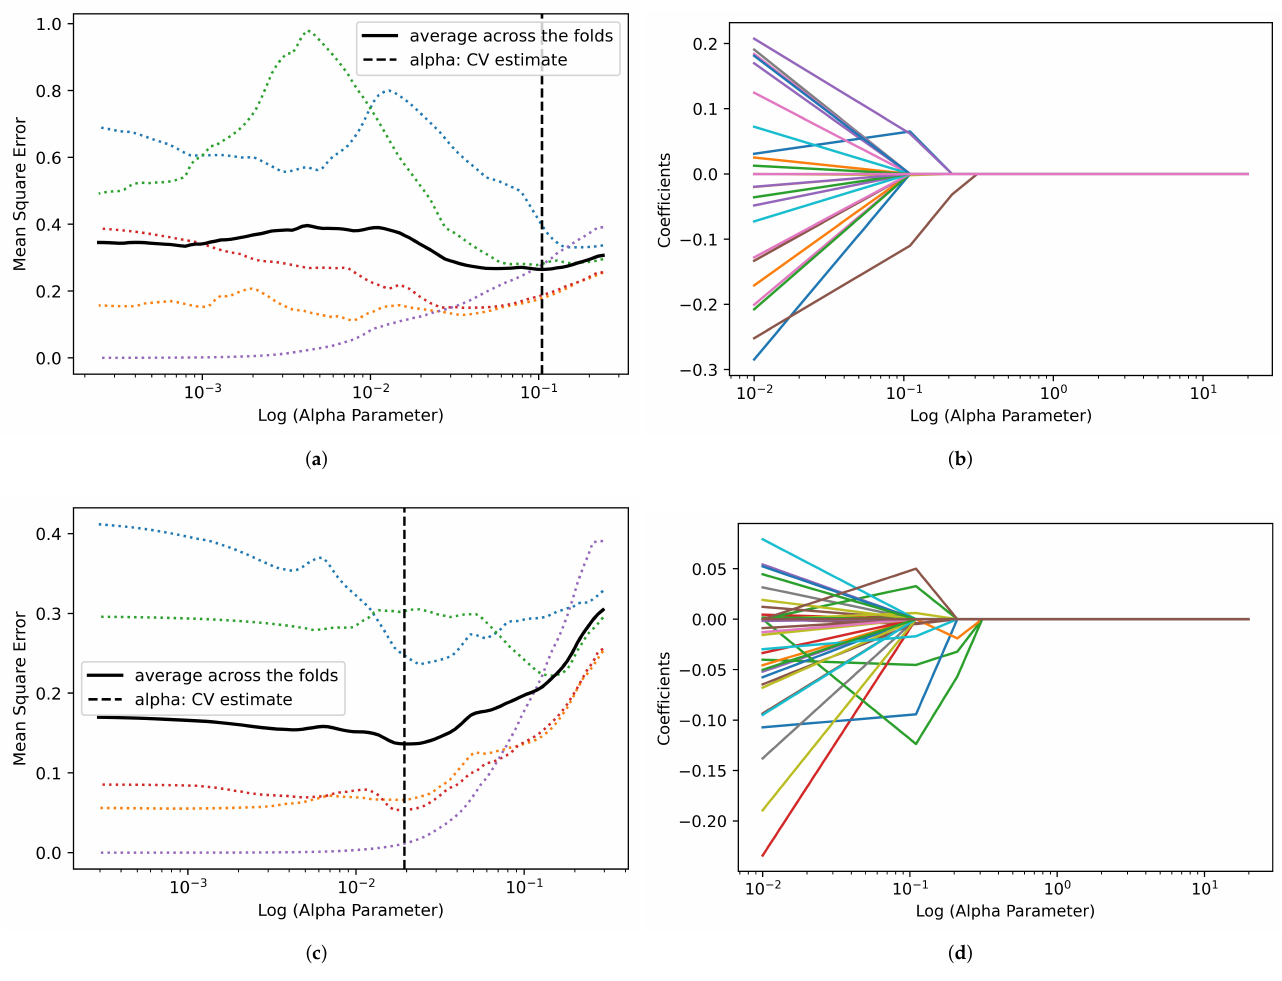
Figure 6. Depiction of LASSO path for 3D Whole Tumor Volume feature selection and best ( α ) parameter estimation in cohort 1. ( a ) Best log ( α ) estimation for 3D original features. The best ( α ) parameter was found to be 0.11. ( b ) 3D original feature selection LASSO path, 4 features were selected. ( c ) Best ( α ) estimation for 3D filtered features. The ( α ) parameter was found to be 0.11. ( d ) 3D filtered feature selection LASSO coefficient path, 10 features were